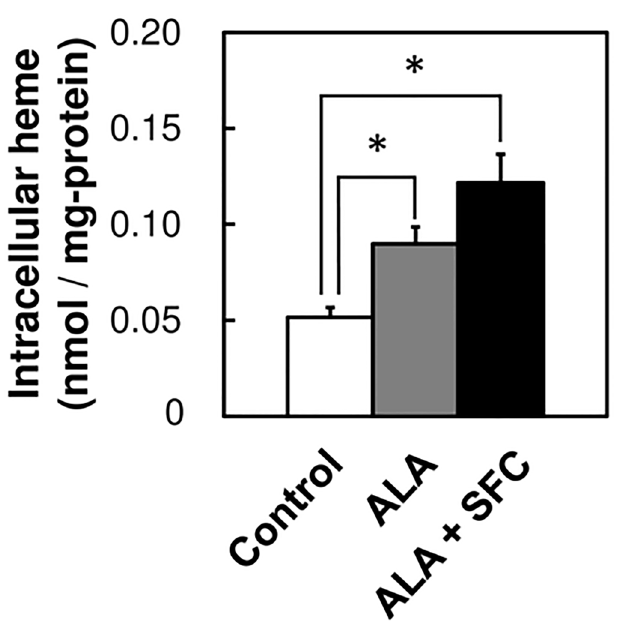
Fig 2. The effect of ALA / SFC on the intracellular heme level. The intracellular heme level was determined by fluoremetric method after incubating MKN28 cells with 1.0 mM ALA, 0.5 mM SFC, or both for 8 h. Data are expressed as means ± S.D. in three independent experiments. Statistical significance of difference is indicated by * p < 0.01 determined with Student ’ s t-test.